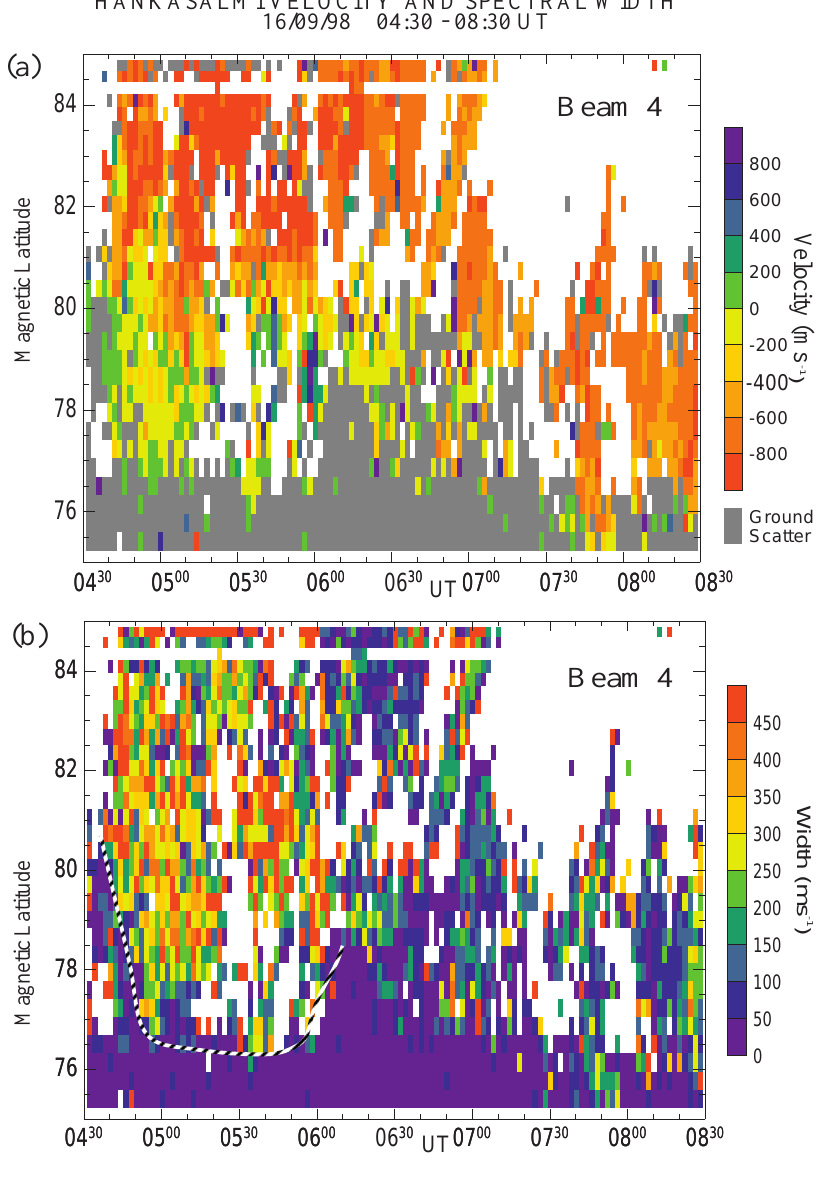
auroral zone field lines. Thus, the open/closed field line boundary is identified at 08:06 UT, at 74.5 ◦ MLAT. Three lines (labelled 1 to 3) have been added to Fig. 5. Line 1 corre- sponds to the position of the spacecraft at 08:05:20 UT when the dispersed ion signatures are first observed. Line 2 identi- fies the spacecraft position at 08:06 UT when the open/closed field line boundary is detected in the electron data, and Line 3 corresponds to the spacecraft position at 08:08:20 UT after which time no more precipitating hot electrons are observed.